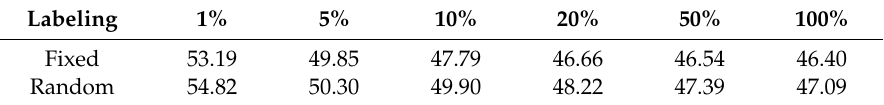
Table 4. FD004 RMSE Unsupervised feature learning with semi-supervised regression.